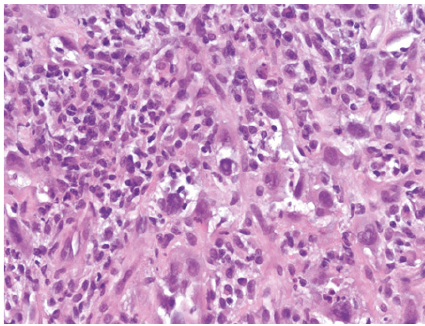
Figure6:Pan-cytokeratinimmunohistochemistry,accentuatingthe epithelial component within the tumour (200x original magnifica- tion).